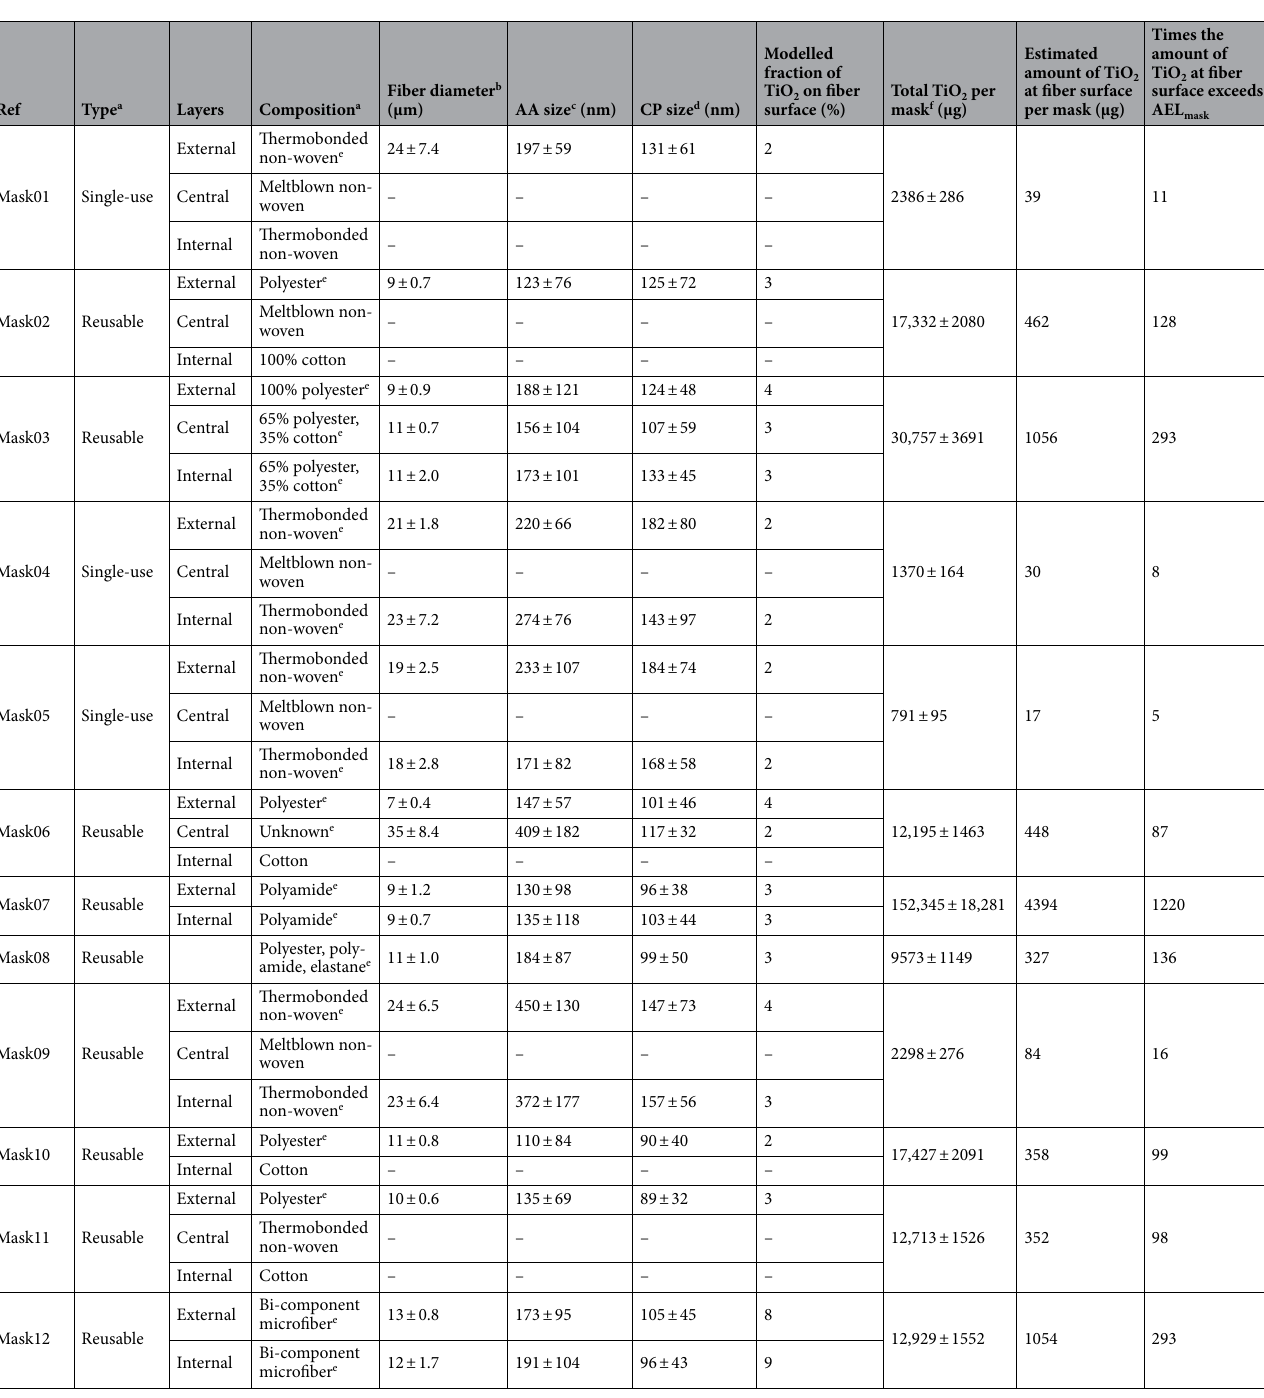
Table 1. Properties of the examined face masks. a As indicated on the packaging or based on expert advice. b Median ± interquartile range (IQR) of the fiber diameter. c Minimum external dimension of the TiO 2 agglomerates (AA) estimated as the median ± interquartile range (IQR) of the minimum Feret diameter distribution. d Minimum external dimension of the TiO 2 constituent particles (CP) estimated as the median ± IQR of the minimum Feret diameter distribution. e TiO 2 particles were observed in this layer by STEM-EDX. f The combined measurement uncertainty (k = 1) on the total mass of TiO 2 per mask was calculated based on an in-house validation study (see Supplementary Information 8). The uncertainty related to the weight of the mask is not included in this